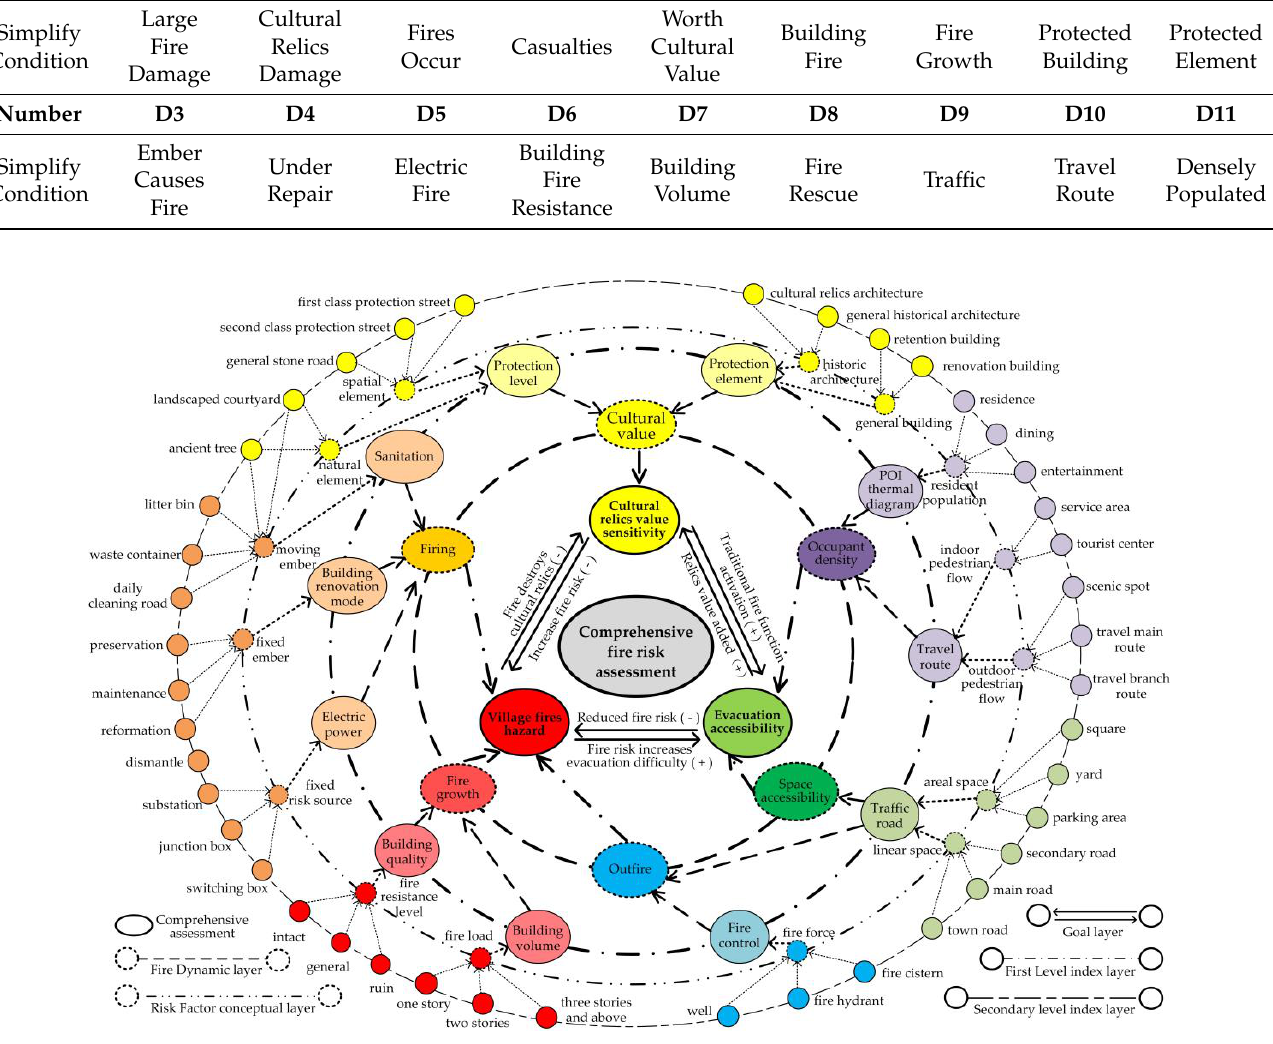
Figure 6. Bayes fire risk assessment index topological